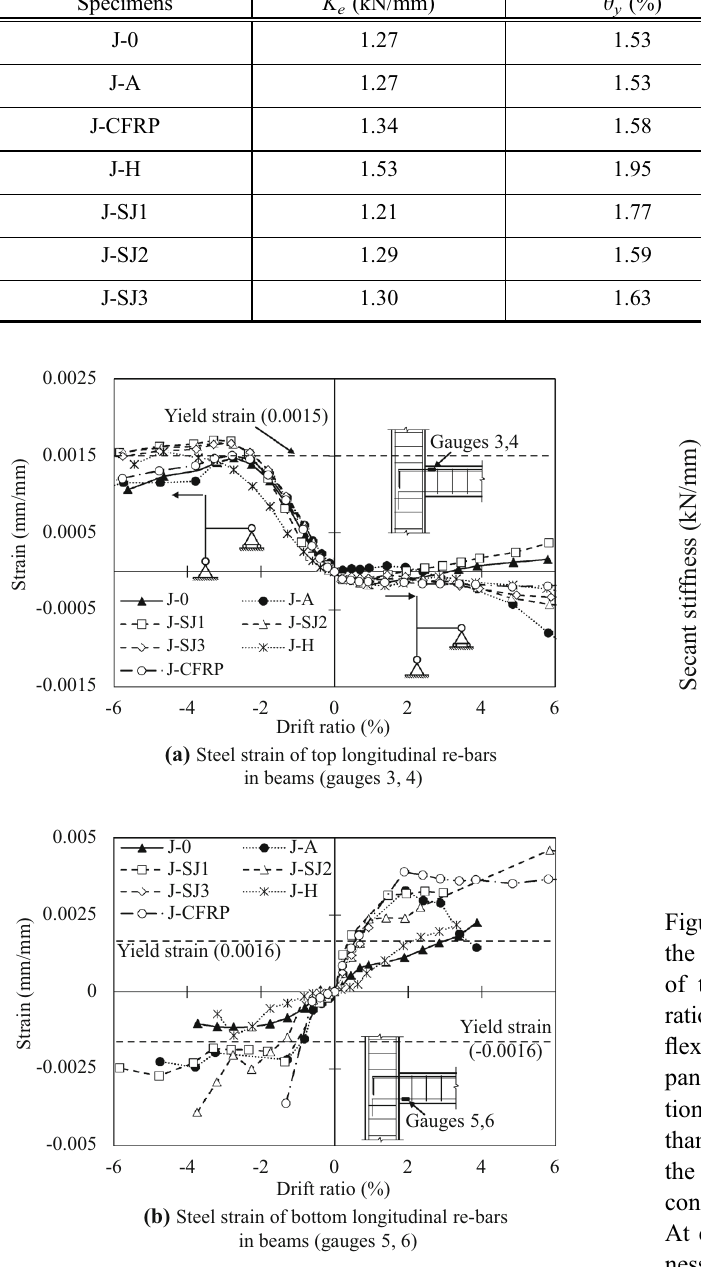
(b) Steel strain of bottom longitudinal re-bars in beams (gauges 5, 6) Fig. 18 Strain profiles for longitudinal steel re-bars in beams.